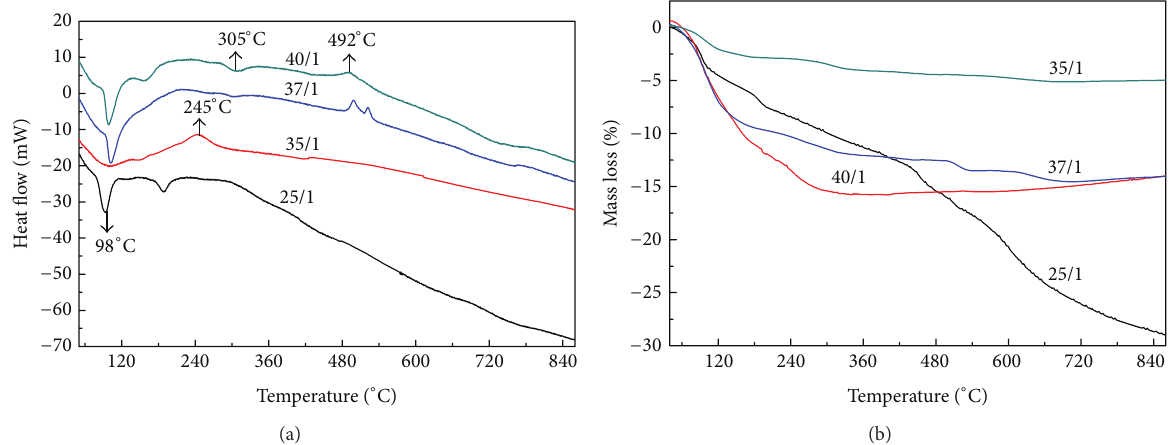
Figure 3: (a) DTA and (b) TG curves of as-milled (K 0.5 Na 0.5 )NbO 3 prepared mechanochemically at 600 rpm for 5 h with different ball-to- powder mass ratios of 25/1, 35/1, 37/1, and 40/1.